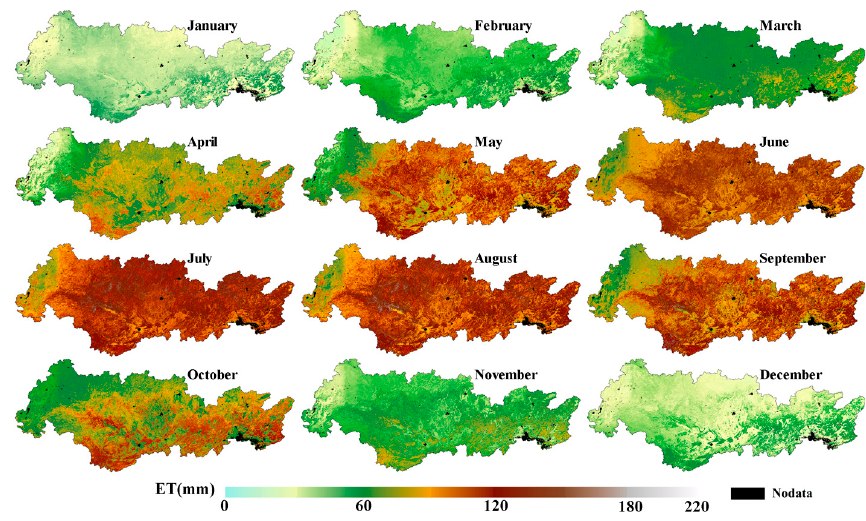
Figure 6. Spatial variation in monthly ET in the PRB.